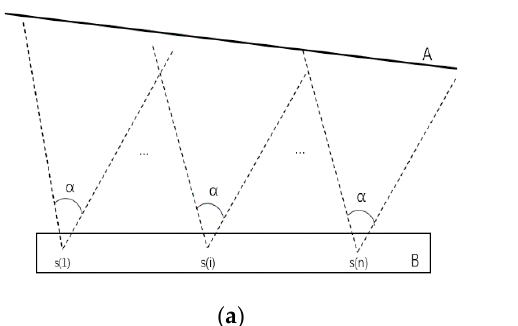
Figure 7. Slope toe simplification: the diagram shows how the broken line is finally reduced to a straight line by line fit- ting.